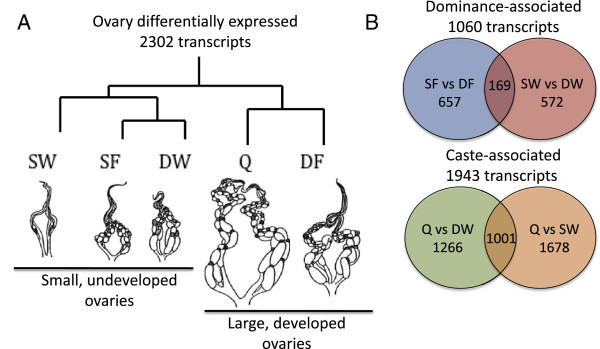
Patterns of gene expression in ovaries of dominant and subordinate wasps. A summary of the ovary microarray data, for 2302 differentially regulated transcripts across the five groups (DF = dominant foundress, SF = subordinate foundress, DW = dominant worker, SW = subordinate worker, Q = queen). A) Consensus clustering analysis (from both principal components analysis and hierarchical clustering) shows that many transcripts showed a pattern that corresponds to gross ovary activation state. Wasp ovary drawings adapted from [39]. B) Venn diagrams summarizing the number of differentially regulated transcripts associated with either dominance status (top) or caste (bottom) and showing the overlaps between contrasts used to identify 'ovary dominance-associated' transcripts (top) and 'ovary caste-associated' transcripts (bottom).